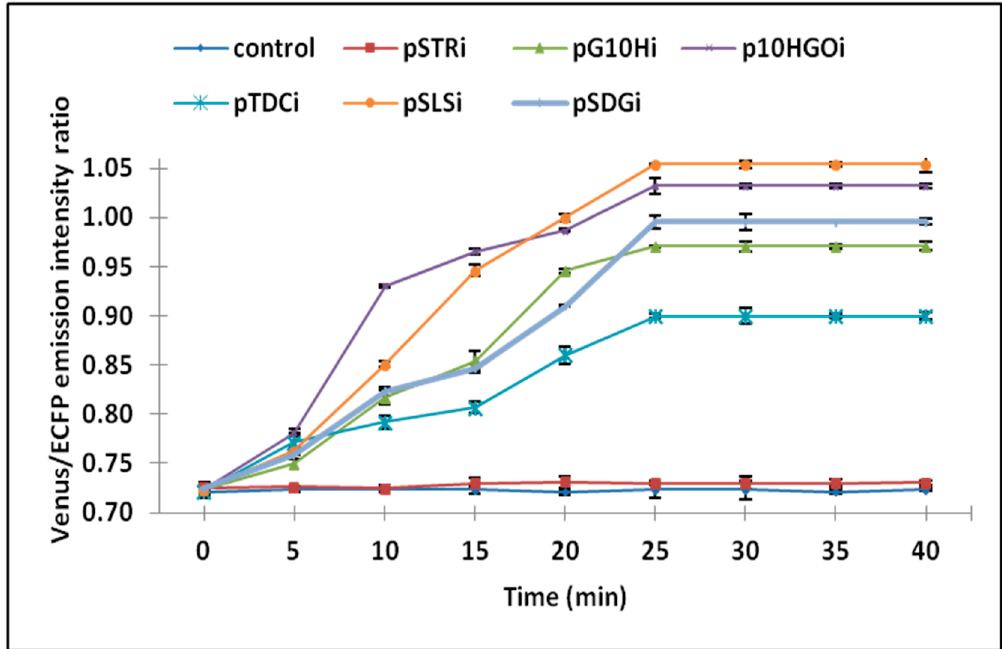
Figure 3. The FRET ratio analysis of the elicited C. roseus cell lines in microplate reader. The line graph represent increased FRET ratio in the cells harbouring silenced G10H, 10HGO, TDC, SLS and SDG, that reached saturation after 25 min. No significant change in the FRET ratio is observed in the silenced STR cells. Values are mean of three independent replicates. Vertical bars represent the standard error.